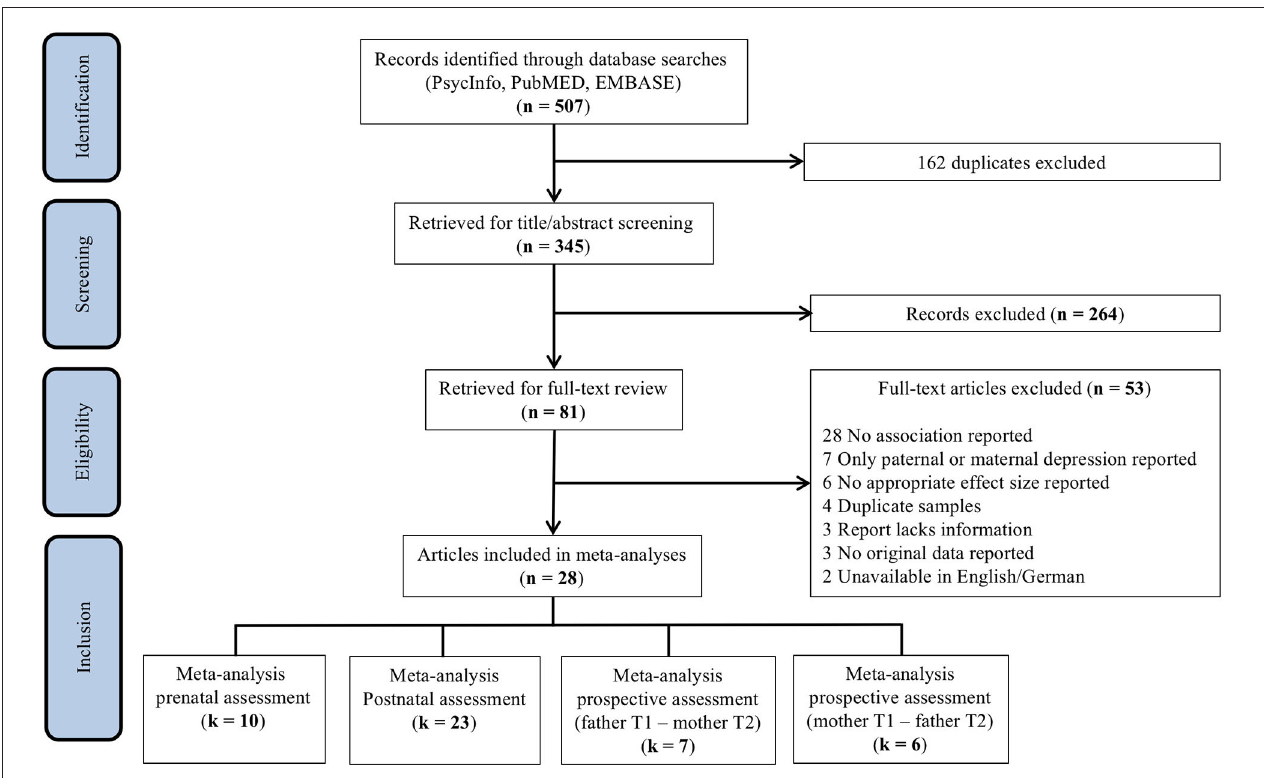
FIGURE 1 | Study selection for inclusion in